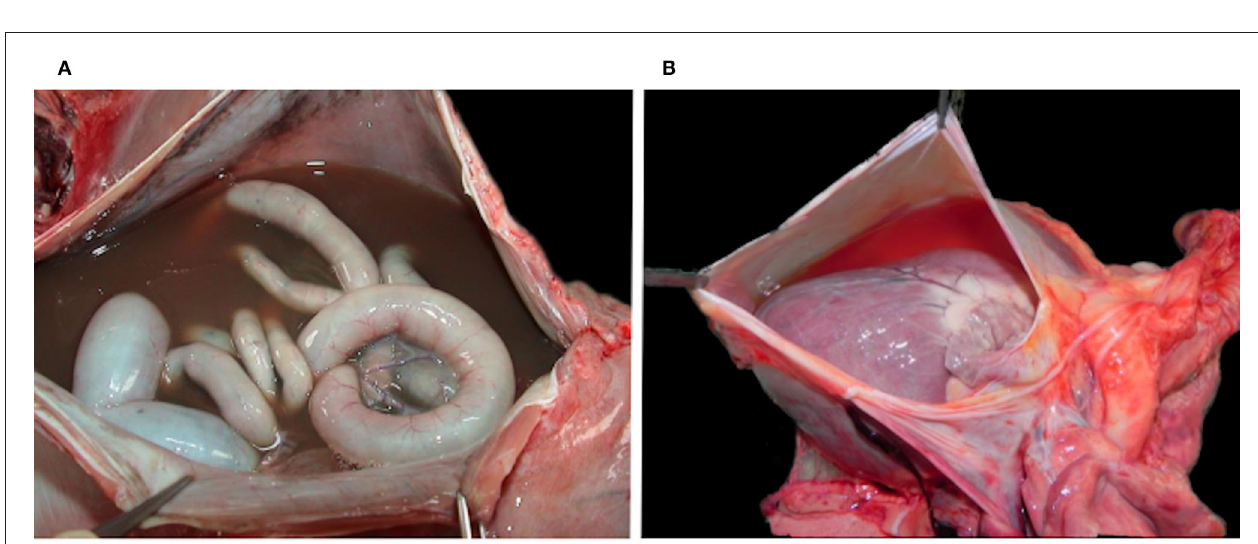
FIGURE 4 | Multisystemic effusions, Eurasian lynx ( Lynx lynx carpathicus ); (A) case 3, abdominal cavity with severe serosanguinous effusion; (B) case 4, pericardial sac filled with a moderate amount of clear orange fluid.